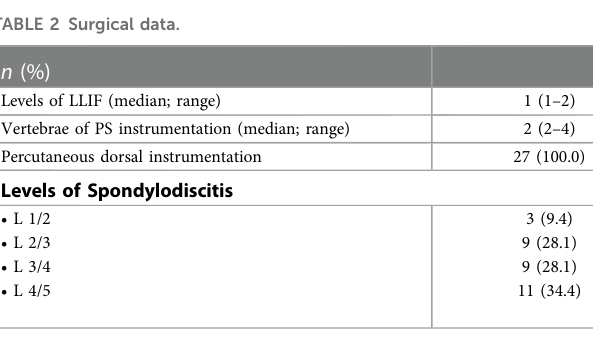
TABLE 2 Surgical